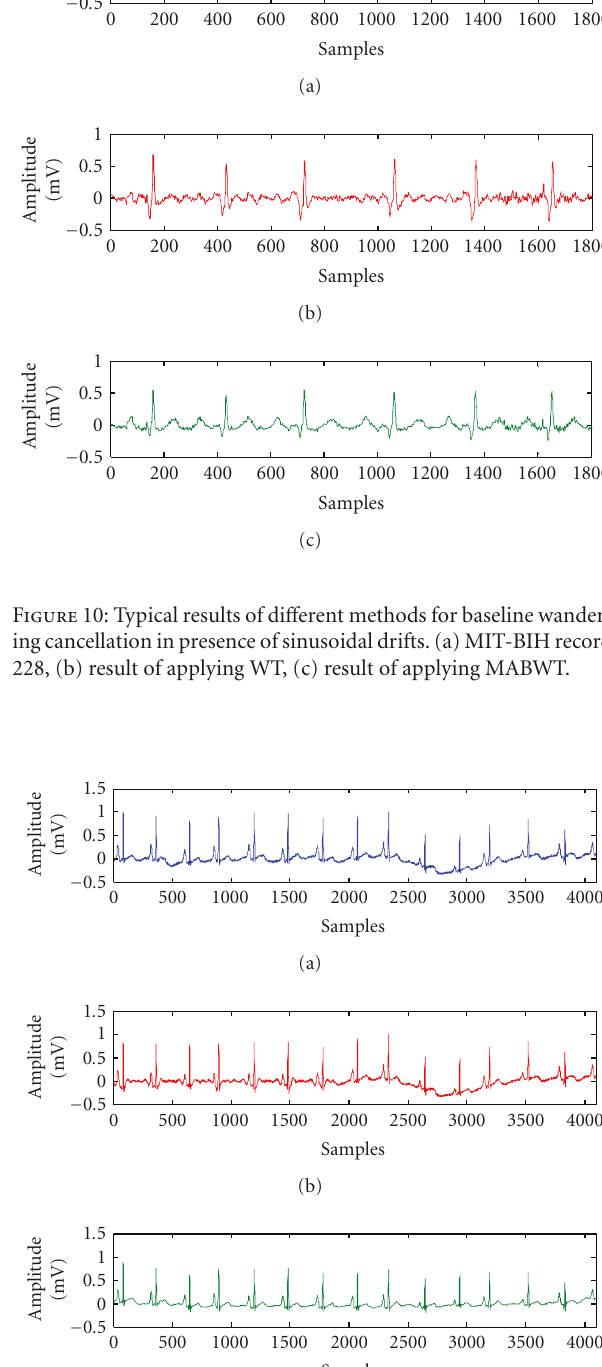
Figure 11: Typical results of di ff erent methods for baseline wan- dering elimination for a non-correlated baseline artifact. (a) MIT- BIH record 222, (b) result of applying WT, (c) result of applying